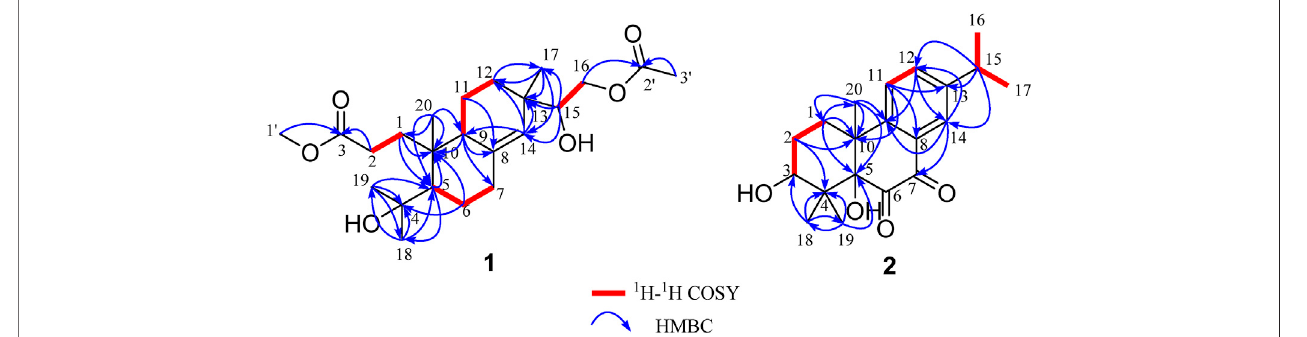
FIGURE 2 | Key 1 H- 1 H COSY and HMBC correlations and the planar structures of 1 – 2.